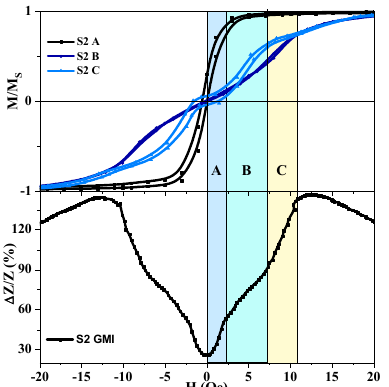
Figure 6. Comparison of the magnetization curves and field dependence of the MI ratio for total impedance of the three-turns Co 75 Fe 10 Ni 2 Si 8 B 5 meander S2. Characteristic field intervals with different curvature of the GMI curves are marked as A, B and C.